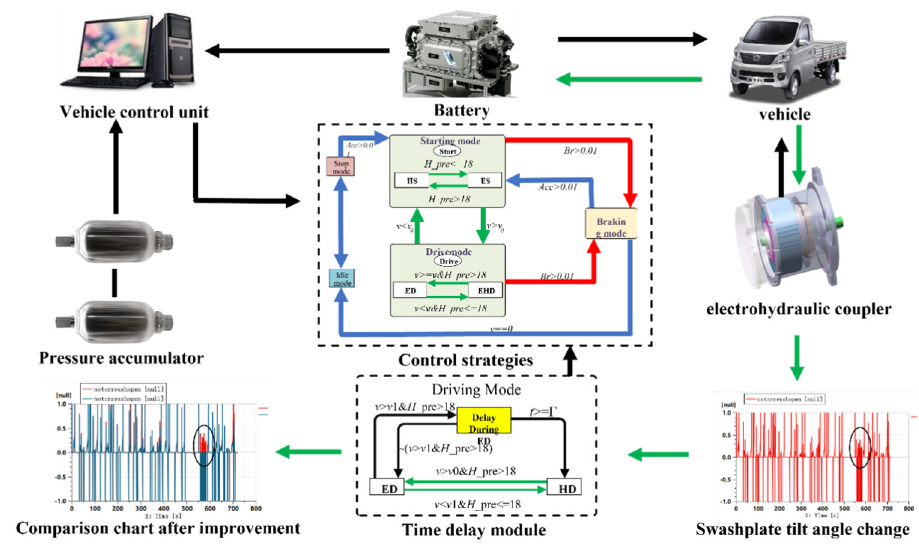
Figure 4. Initial control strategy diagram.